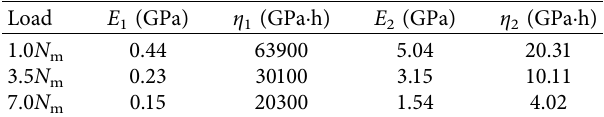
Figure 19: 3D calculation model comprised of model anchor and surrounding rock. Table 2: Input parameters of Burger’s model used for surrounding